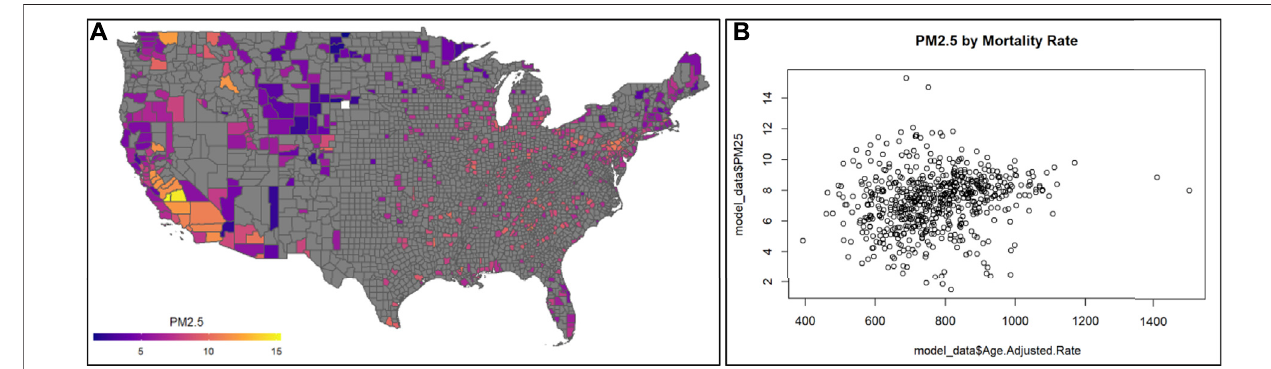
FIGURE 11 | Example visualizations of (A) air quality data, highlighting the 2016 annual PM 2.5 concentrations across U.S. counties, and (B) potential relationships against mortality rates. Code that supports the generation of these visualizations and example statistics evaluating trends between air pollution and mortality rates, and analyses including potential confounders, is described within this training